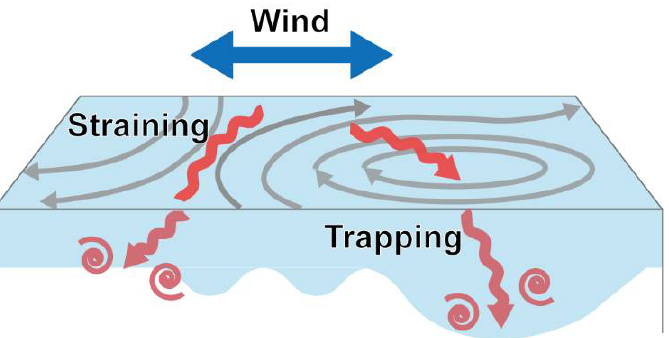
Figure 1. Schematics on interaction between mesoscale flow field (grey line) and wind-induced NIWs (red arrow), enhancing the near-inertial kinetic energy. Red spirals indicate dissipation of NIWs.